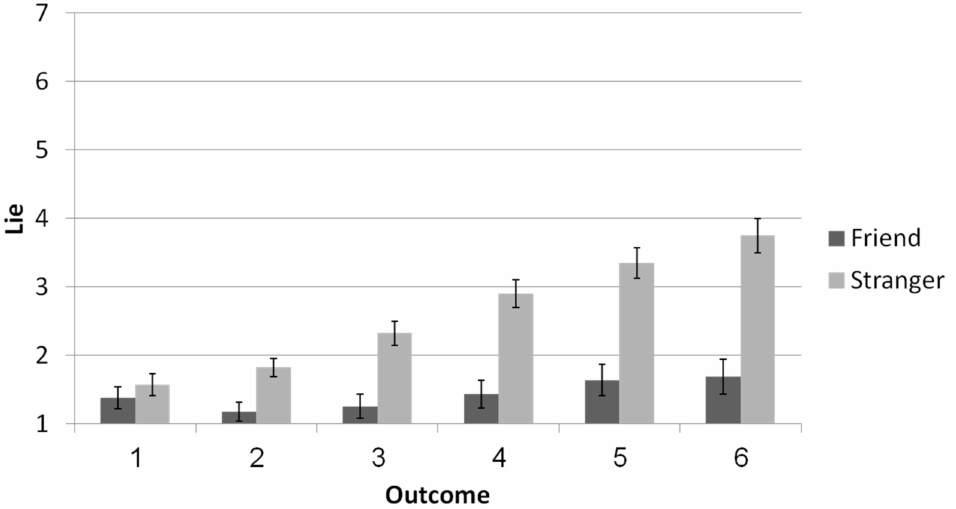
Figure 1. Perceived lie as a function of interaction partner and outcome (Error bars are +1 SE around the